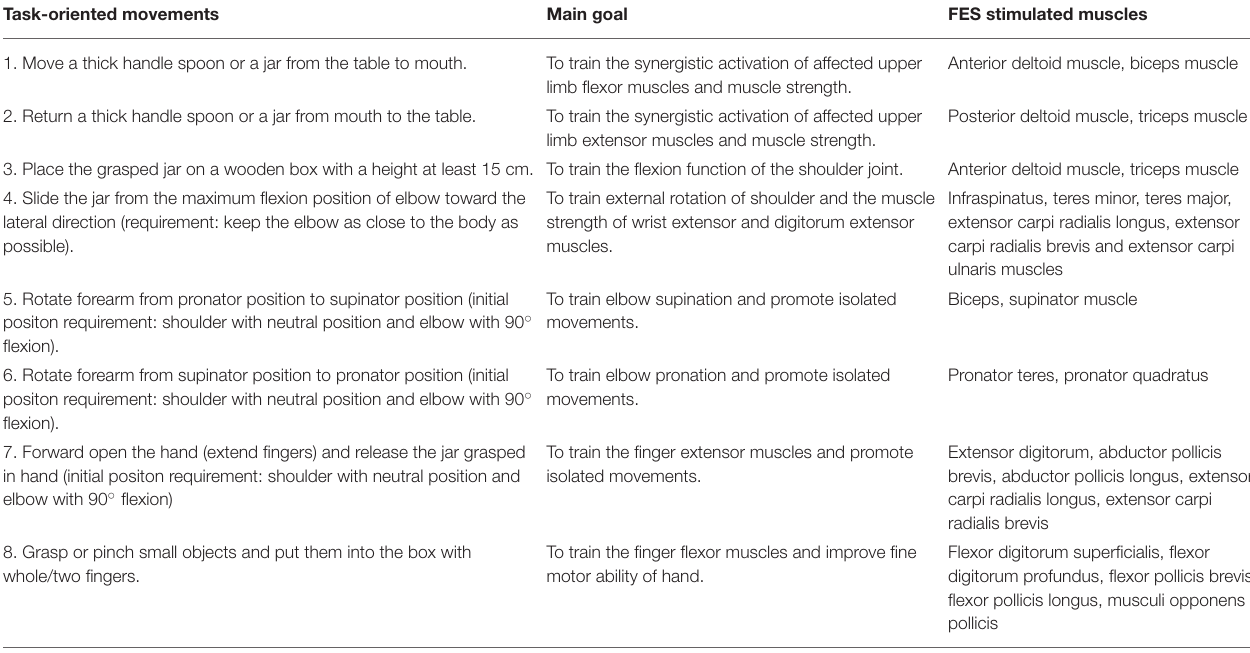
TABLE 2 | The motor tasks and the task-specific stimulated muscles. Task-oriented